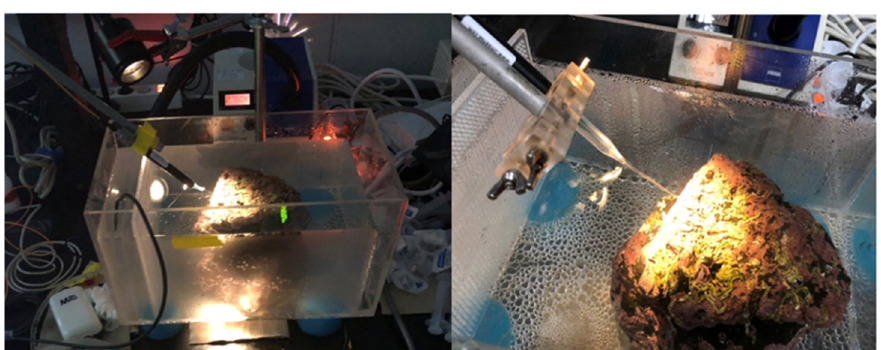
Figure 2. Images of the experimental setup. The O 2 profiles were measured using an oxygen microsensor with control of the water temperature and irradiance in a constant-flow chamber.